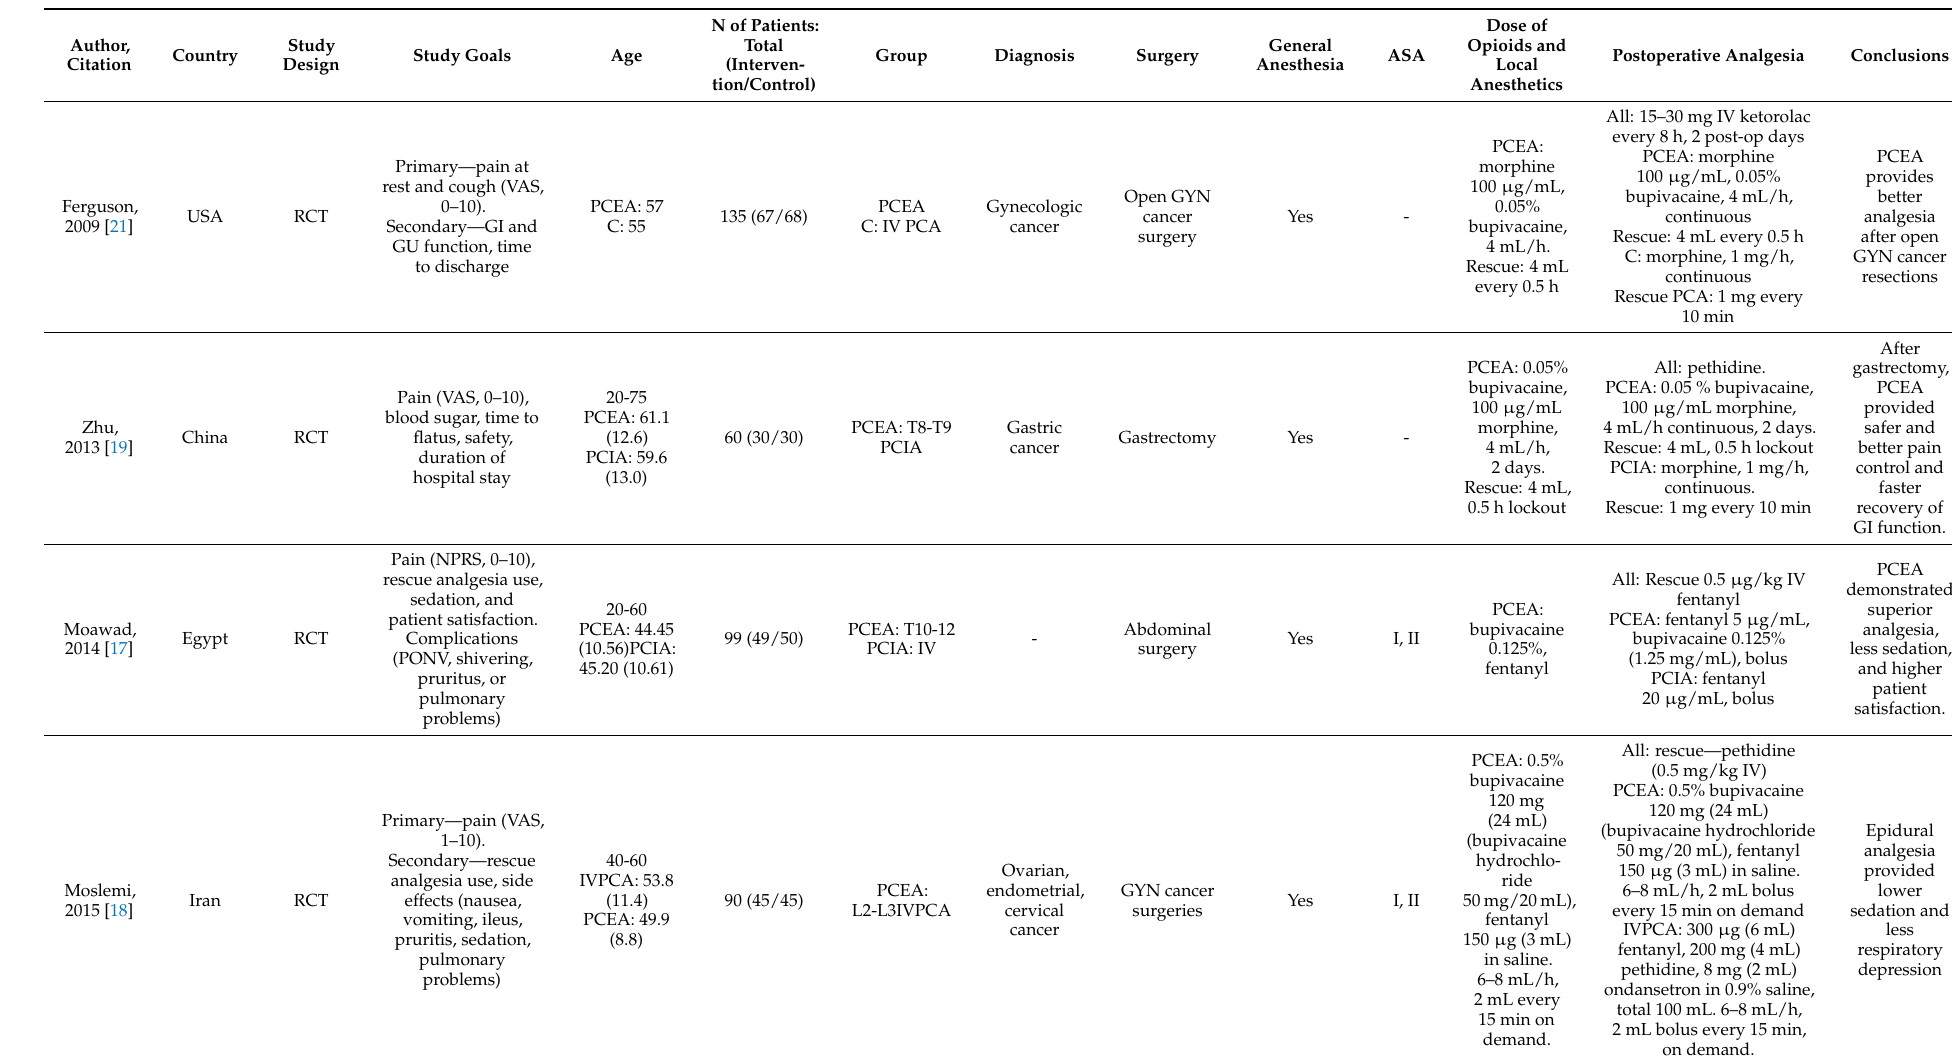
Table 1. Characteristics of the studies included in the